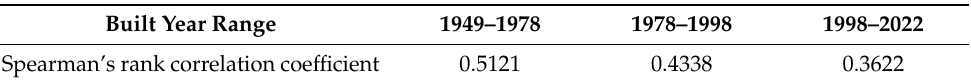
Table 2. Spearman’s rank correlation coefficients between locations and built